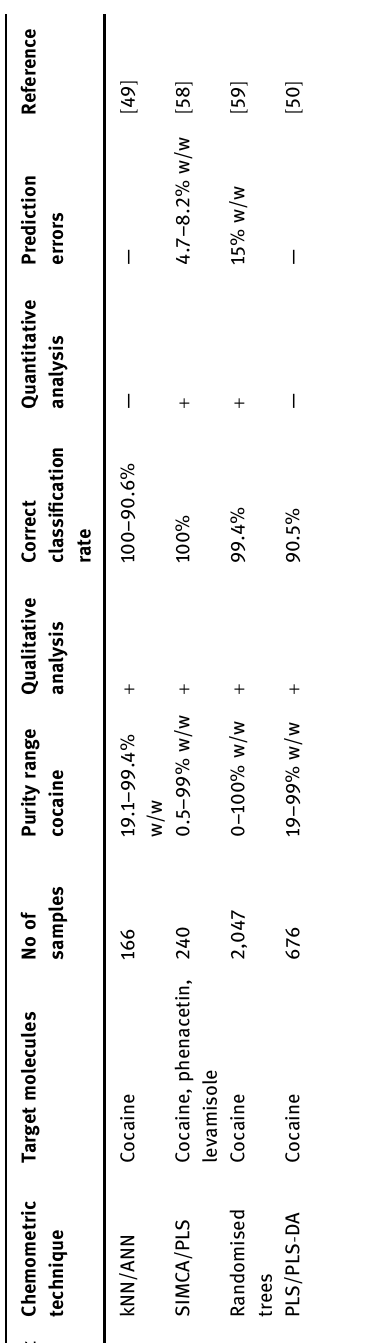
aminopyrine, lidocaine, ca ff eine, and levamisole ( PLS ) .